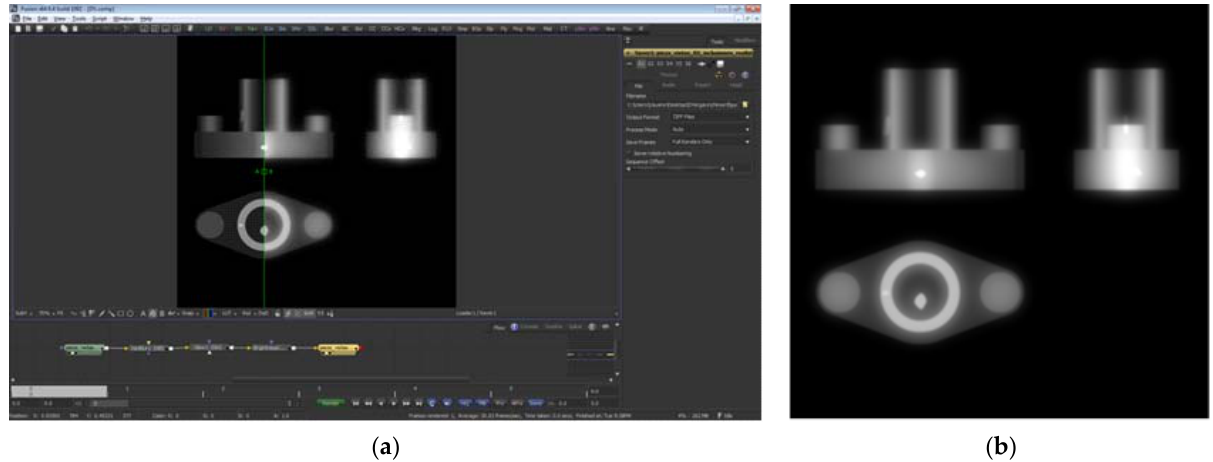
Figure 7. Image simulating a real radiograph: ( a ) manipulation of an image by means of BDF to obtain an image similar to a real radiograph; ( b ) realistic ‐ looking radiographic image.